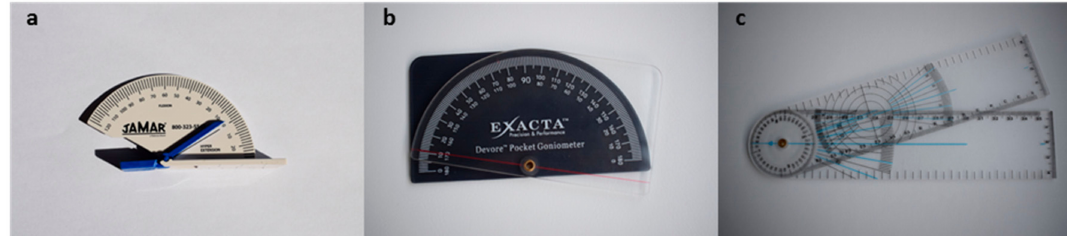
Figure 3. Goniometers used in this study: ( a ) Rolyan finger goniometer with loose-fitting hinge; ( b ) Devore pocket goniometer; and ( c ) universal goniometer with full-circle